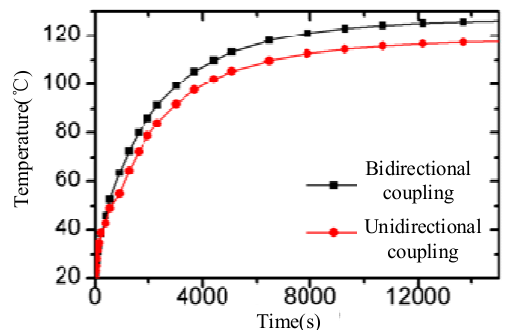
Figure 15. The temperature rise of the winding.